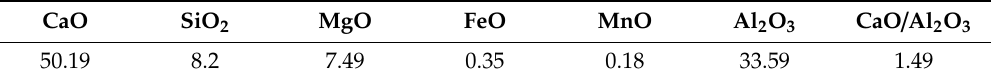
Table 3. Average composition of refining slag (wt%).